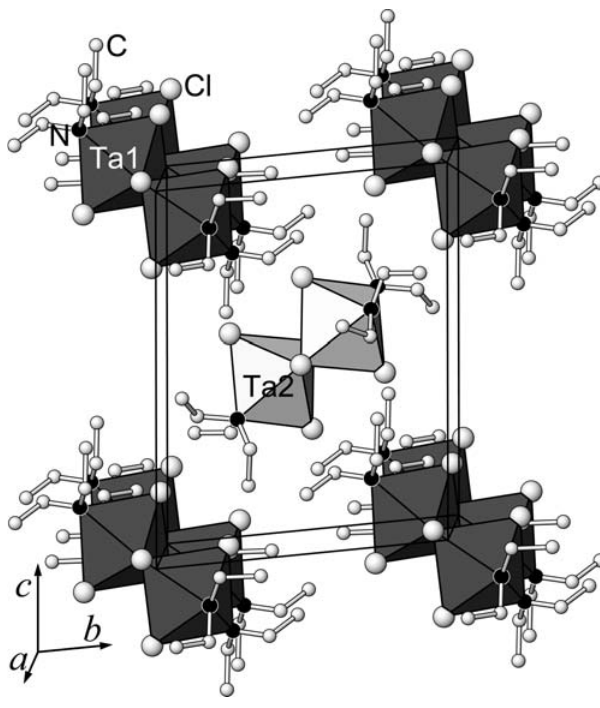
Table 2. Atomic coordinates and displacement parameters (in Å 2 )